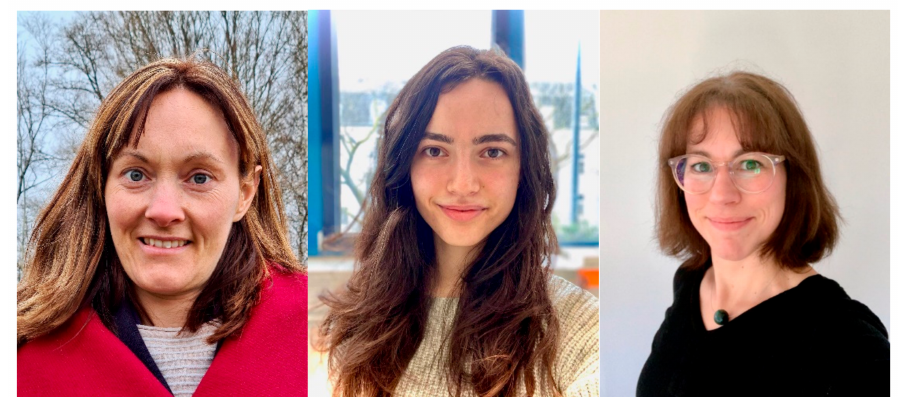
Figure 3. Marie Agatha Mohn, Besarta Thaqi and Katrin Fischer-Schrader (from left to right). Nitrate reductase is the key enzyme in the nitrate assimilation pathway of plants, and is also suggested to be a major enzymatic source of the signaling molecule nitric oxide, produced by nitrite reduction. Arabidopsis thaliana possesses, like many plants, two isoforms of nitrate reductase, NIA1 and NIA2. In our study, we systematically compared both NIA isoforms, with a focus on their kinetic properties, and our data suggest that both NIA1 and NIA2 fulfill distinct functions in plant physiology. Based on their enzymatic characteristics, NIA1 is likely to be involved in cellular signaling, due to its significant reduction of nitrite to nitric oxide, whereas NIA2 is considered to function primarily in nitrogen metabolism, reducing nitrate to nitrite.